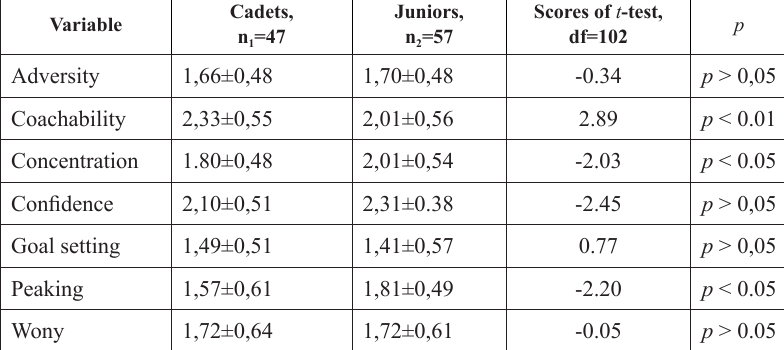
*Note ( M ± SD ) – mean and standard de -